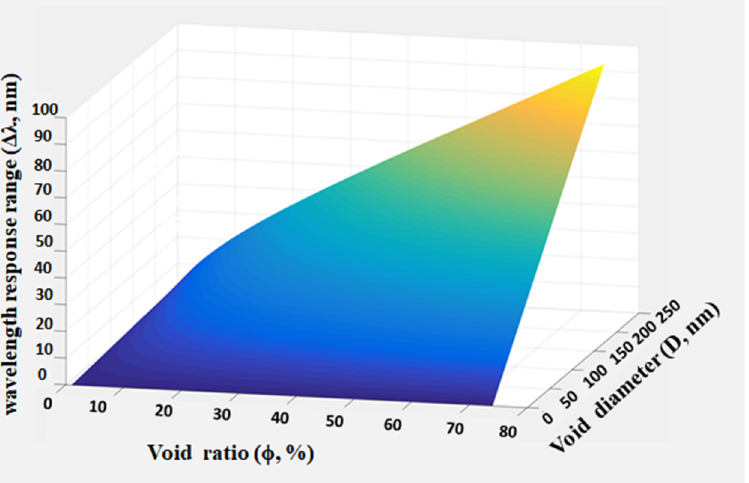
Figure 4. Typical examples of wavelength response range ( Δ λ PEGDA ) of the PC sensor as a function of void ratio ( ϕ ) and void diameter ( D ).